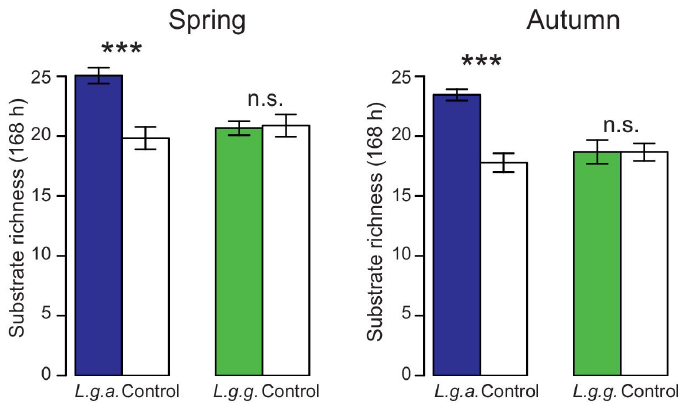
Figure 11. Substrate richness (168 h) in Lamium galeobdolon subsp. argentatum plots, Lamium galeobdolon subsp. galeobdolon plots and corresponding control plots in both spring and autumn. Mean values ± s.e. are shown, n = 18. Di ff erences were tested using paired t -tests; *** p < 0.001, n.s. not signi fi cant).